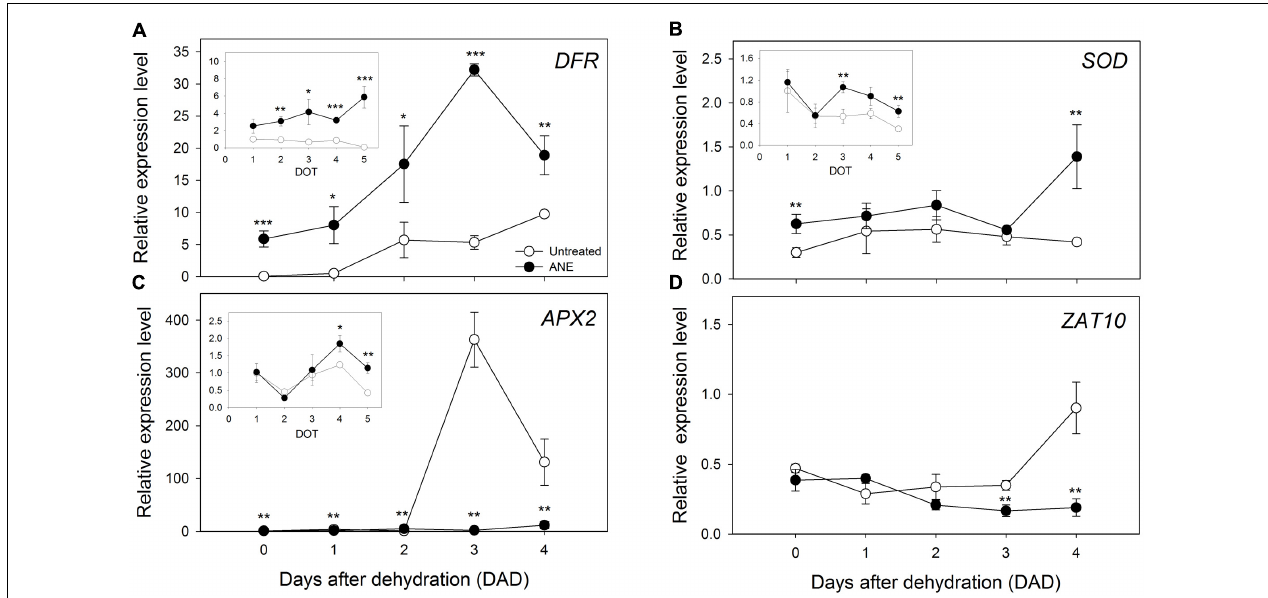
FIGURE 7 | Pattern of expression level for genes involved in ROS scavenging and responsive processes. Time 0 is the dehydration stress starting time and it corresponds exactly with the last day of Ascophyllum nodosum extract (ANE) treatment. Expression analysis of DFR (A) , SOD (B), and APX2 (C) for 5 days of treatment (1–5 DOT, inset) and from 0 to 4 days after dehydration (0–4 DAD). Expression analysis of ZAT10 (D) from 0 to 4 DAD. Each dot shows the mean ± SE of four biological replicates. Untreated (white dot) and ANE-treated (black dot) samples were analyzed by one-way ANOVA ( P < 0.05), ∗ P ≤ 0.05; ∗∗ P ≤ 0.01; ∗∗∗ P ≤